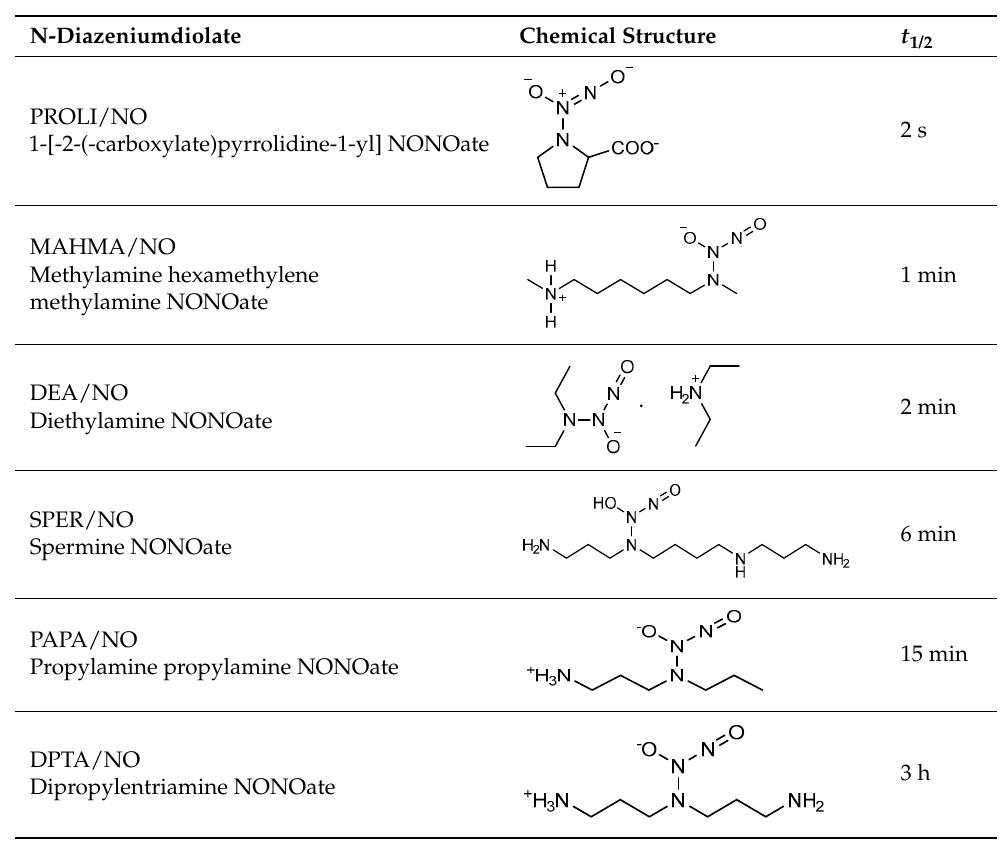
Table 2. Chemical structure and approximate half-life values, t 1/2 , of NONOates at 37 °C and pH 7.4. Adapted from [81].